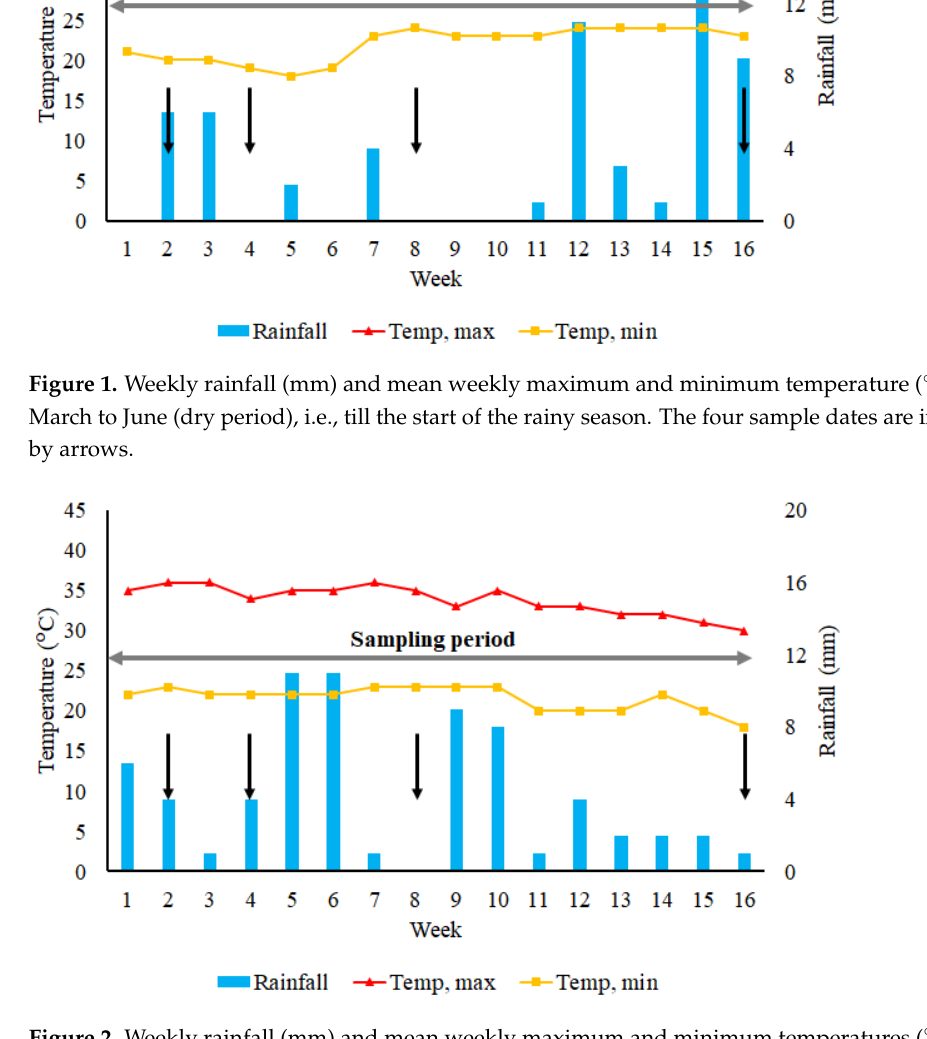
Figure 2. Weekly rainfall (mm) and mean weekly maximum and minimum temperatures (°C) from August to November (wet period). The four sample dates are indicated by arrows.